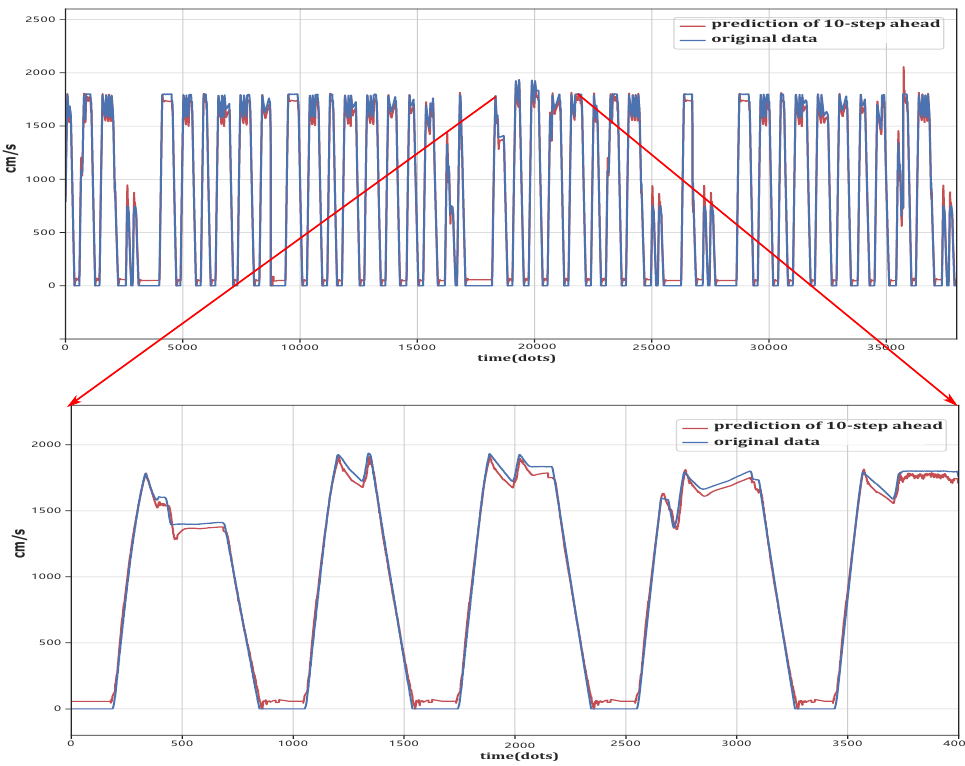
Figure 8. Comparison of the original data and the output of 10-step-ahead prediction.